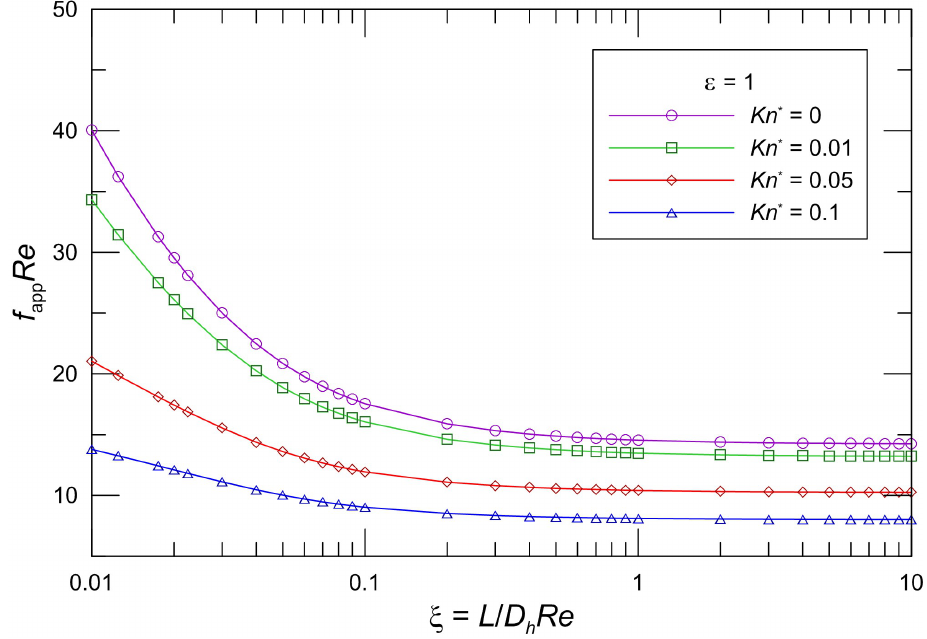
Figure 4 . Effect of Kn * on f app Re for rectangular ducts ( ε = 1). Figure 4. Effect of Kn * on f app Re for rectangular ducts ( ε =